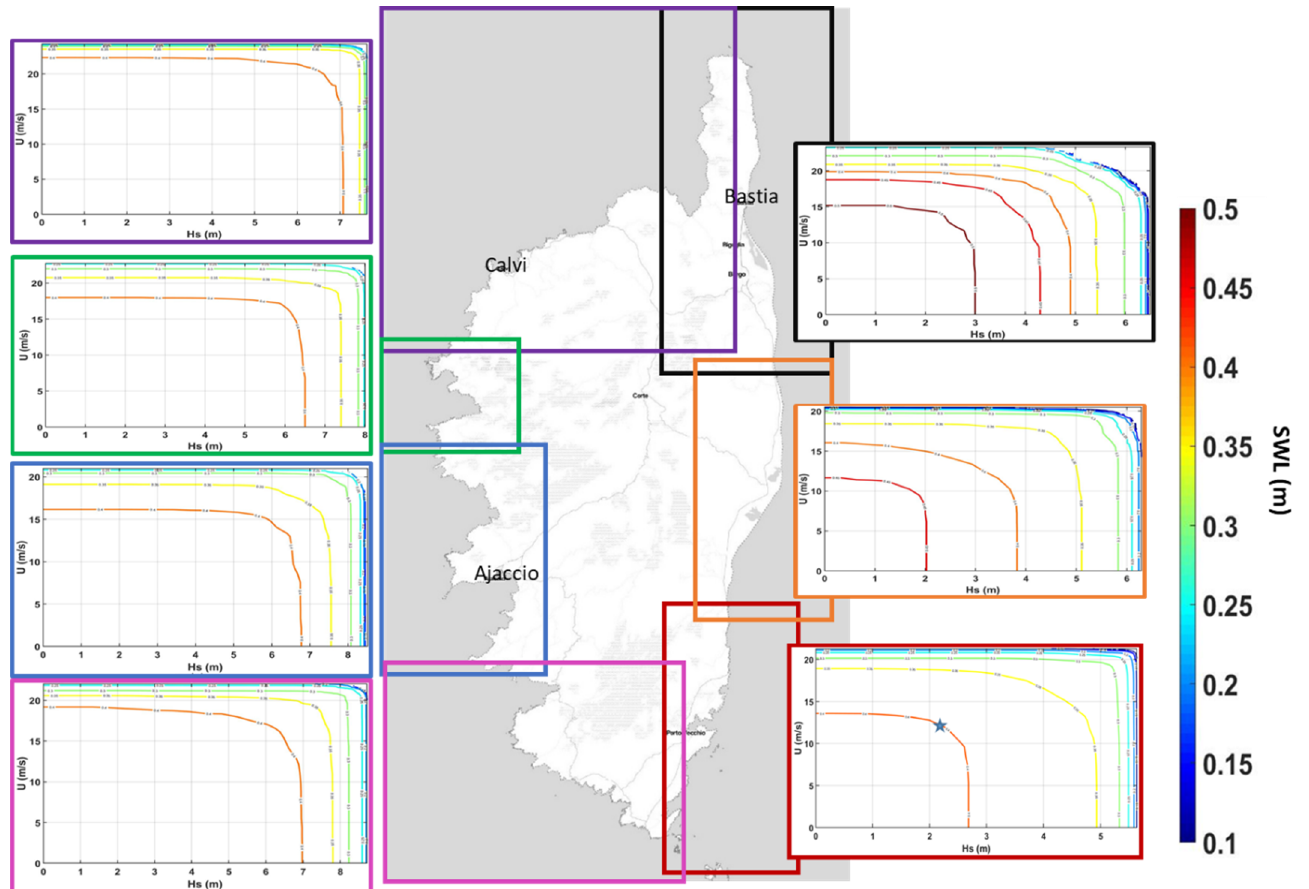
Figure 8. The 100-year joint exceedance isocontours for all of the boxes (in color) analyzed around Corsica, the colorbar corresponds to SWL (m).